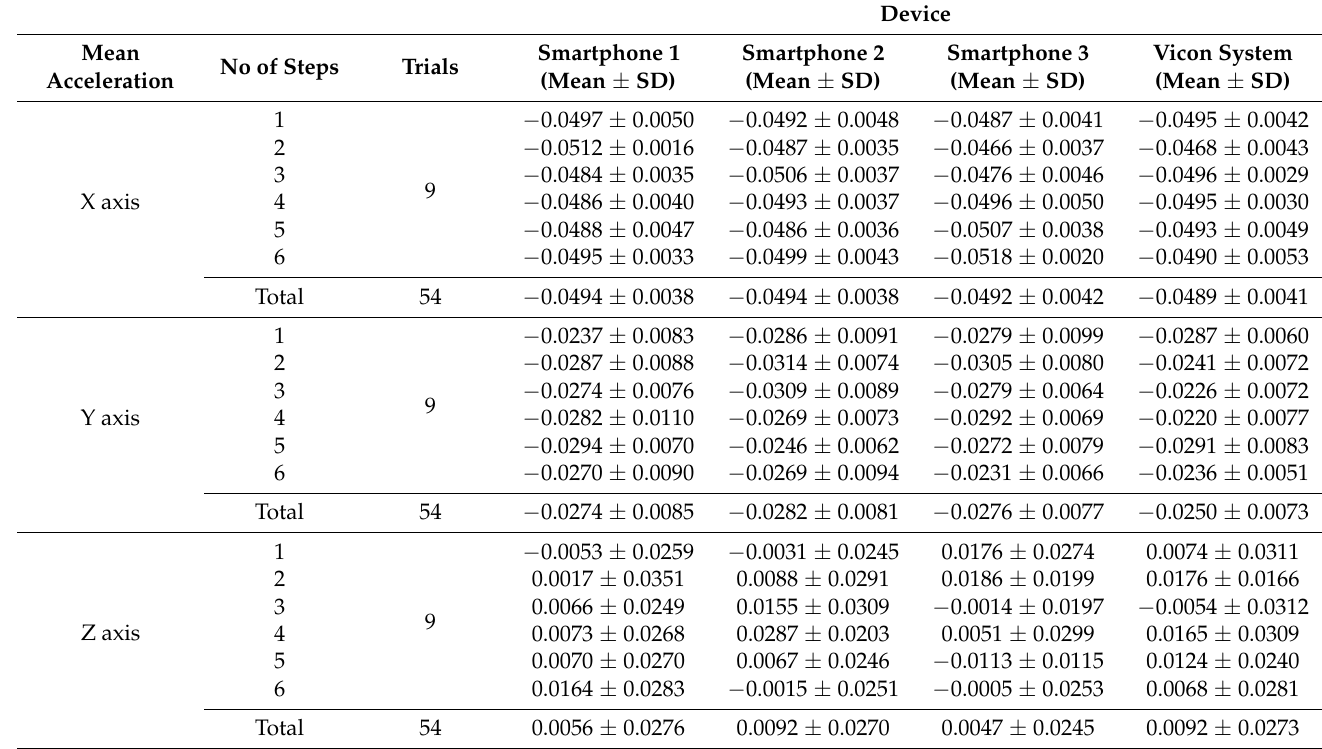
Table 3. Pearson r correlations from each device linear acceleration’s data on the X axis.